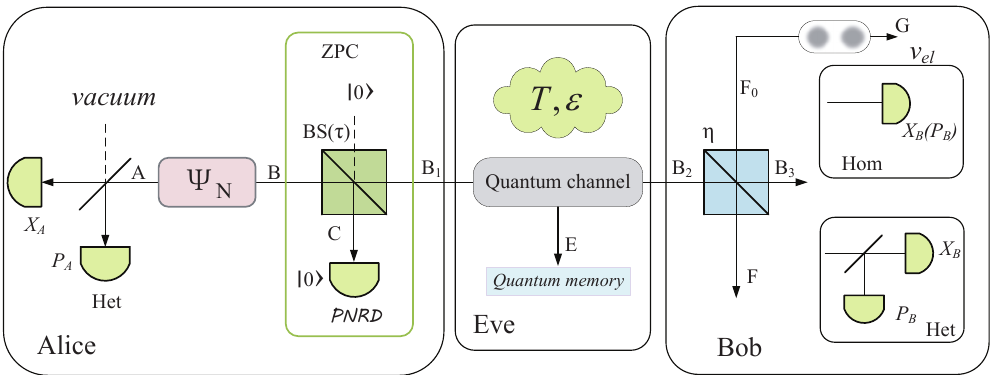
Figure 3. Schematic diagram of continuous-variable quantum key distribution (CVQKD) with zero-photon-catalysis (ZPC)-based DM source preparation.